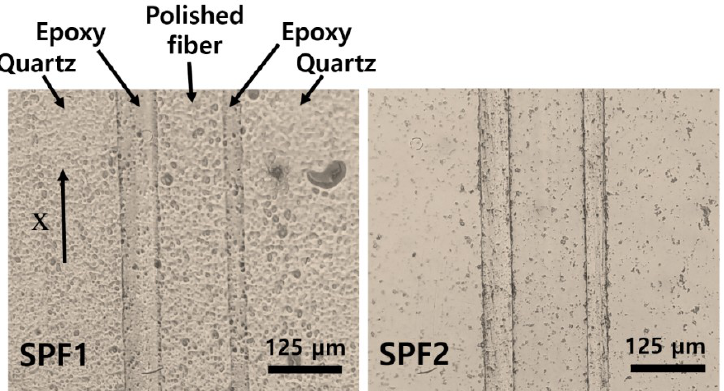
Figure 1. Top views of two side-polished fiber (SPF) sensors with different surface roughness. The left arrow indicates the direction of x-axis defined here as parallel to the longitudinal direction of fiber.